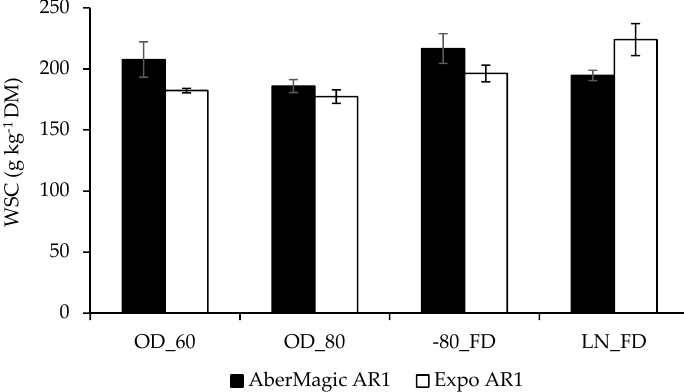
Figure 2. Water-soluble carbohydrate (WSC) concentration as a ff ected by cultivar and drying procedure for the first sampling (December 2016; late spring). OD_60: oven-drying at 60 ◦ C for 48 h, OD_80: oven-drying at 80 ◦ C for 16 h, − 80_FD: freezing at − 80 ◦ C for 48 h followed freeze-drying, LN_FD: liquid nitrogen followed freeze-drying. Vertical bars represent the standard error of the